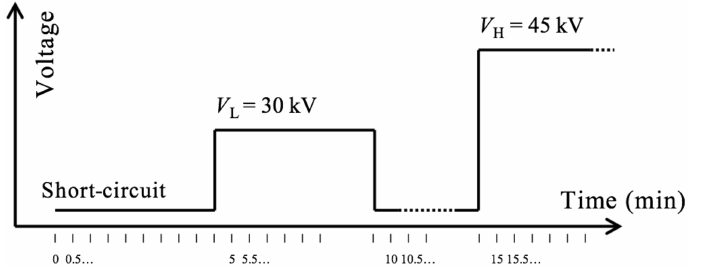
Figure 1. Schematic of the measurement schedule. Waveforms obtained under short-circuited and voltage-applied conditions are subtracted to create the data to be